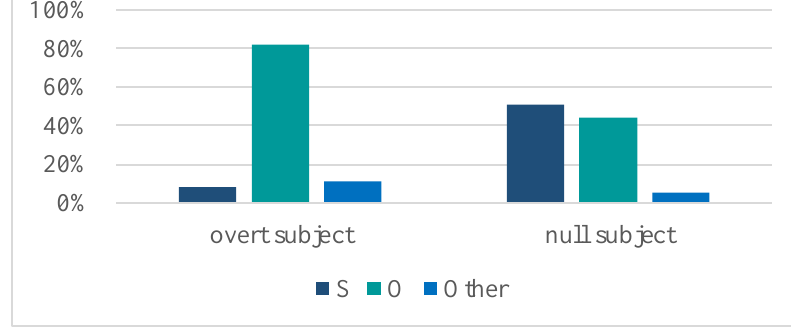
Source : Sorace & Filiaci (2006: